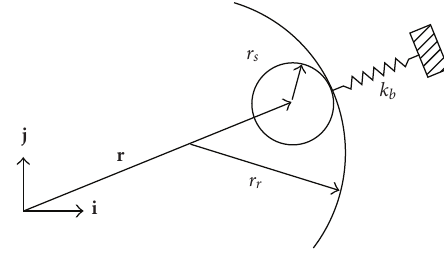
Figure 1: Single pedestal unit